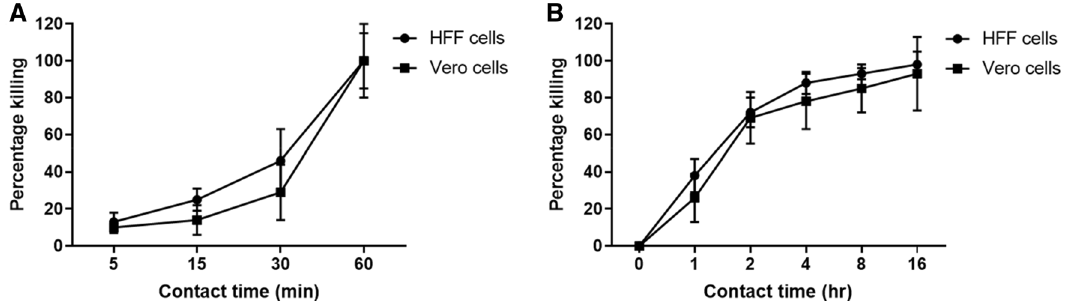
Figure 3. Kinetic profile of the antibacterial activity of AgNPs against extracellular ( A ) and intracellular ( B ) A. baumannii . HFF or Vero cells were co-cultured with A. baumannii and AgNPs (25 μg/ml) were added. Extracellular killing was evaluated by plating the mixture on Mueller–Hinton agar plates and determination of the CFU, while intracellular killing was evaluated by lysing the cells with Triton X-100 following by culture. The percentage of killing caused by the AgNPs was calculated at the indicated time points relative to the control untreated cells. Experiment was performed in triplicate and the mean ± standard deviation is shown.